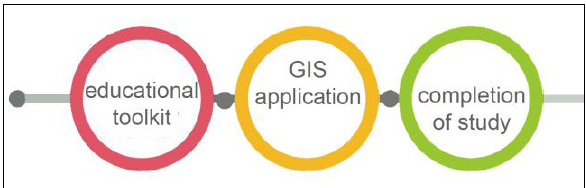
Figure 5 . Overall workflow of the presented